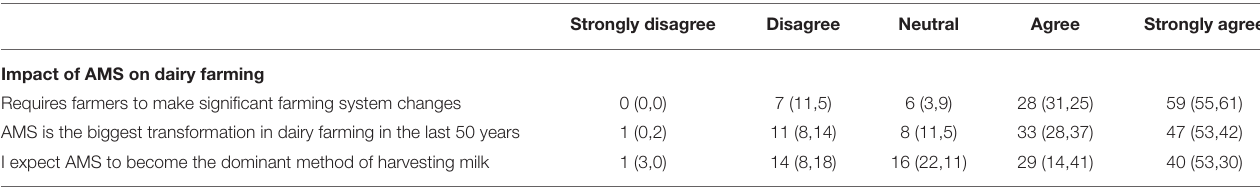
TABLE 4 | Respondent opinions regarding the impact of AMS on dairy farming. Results are presented as percentages, with retailer, non-retailer in brackets, respectively.